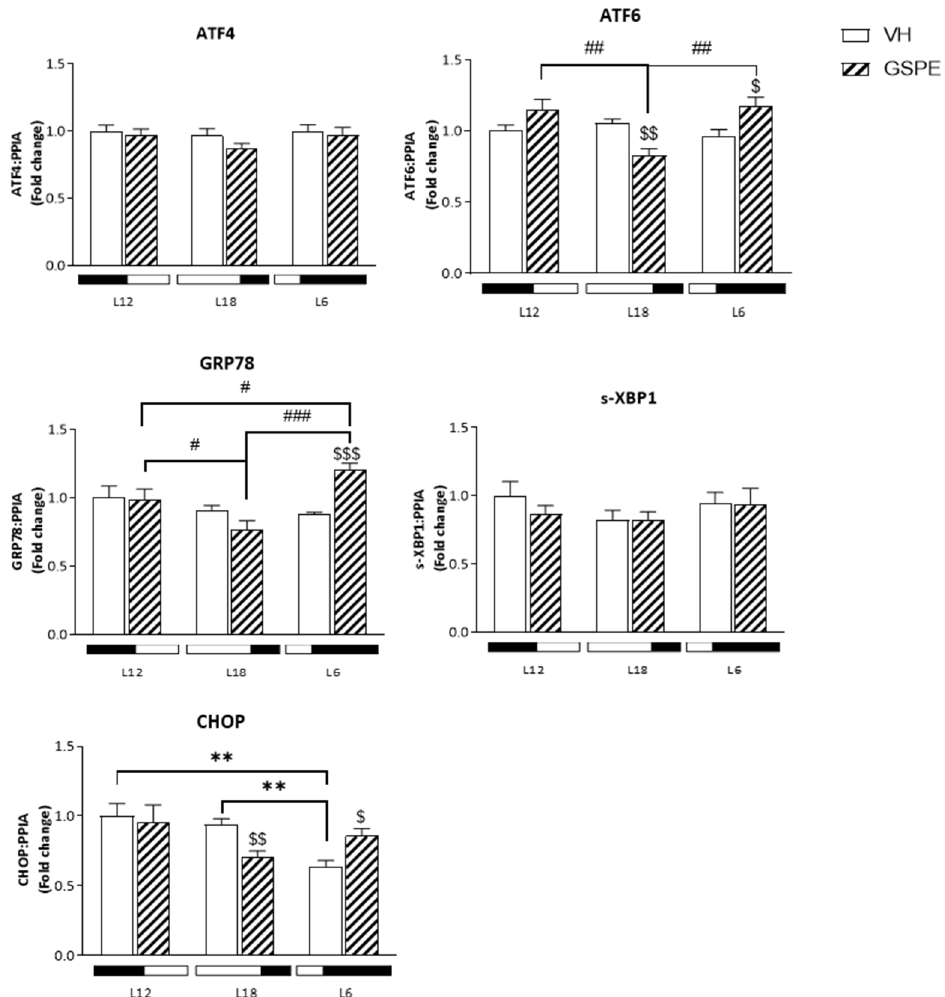
Figure 6. mRNA expression levels of ER stress genes of Fischer 344 rats treated with VH or GSPE exposed to standard (12 h light:12 h dark), long (18 h light:6 h dark), or short (6 h light:18 h dark) photoperiods fed with STD diet ( n = 8). The results are presented as the mean ± S.E.M. * indicates significant differences within VH groups (Student’s t test, ** p < 0.01); # indicates significant differences within GSPE groups (Student’s t test, # p < 0.05, ## p < 0.01, ### p < 0.001); $ indicates significant differences between treatments (VH vs. GSPE) (Student’s t test, $ p < 0.05, $$ p < 0.01, $$$ p < 0.001).